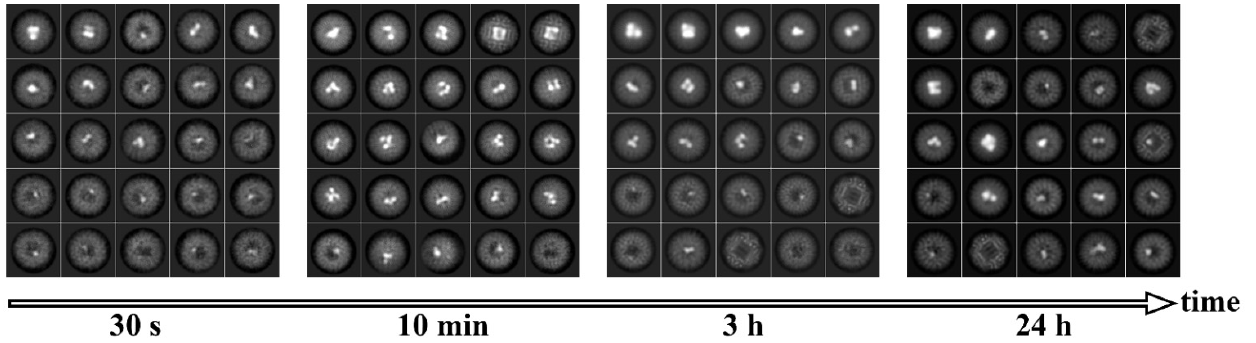
Figure 2. Class averages of Dps dodecamers with an estimated iron loading of 2000 atoms after incubation for 30 s, 10 min, 3 h and 24 h (left to the right). Each of 2D class averages is 12.5 nm wide.